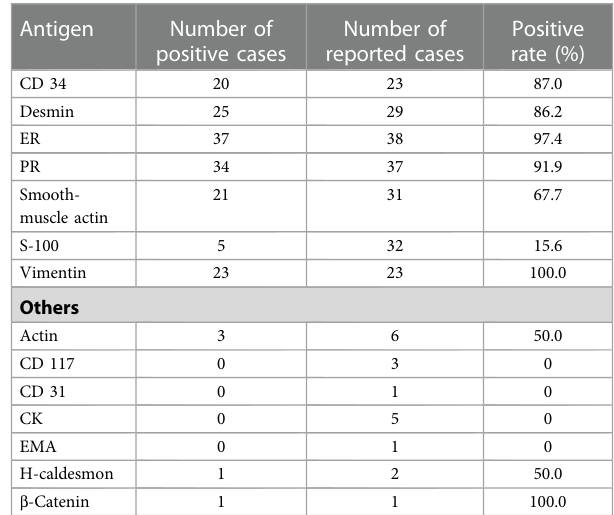
TABLE 4 Immunohistochemical main antigen expression of